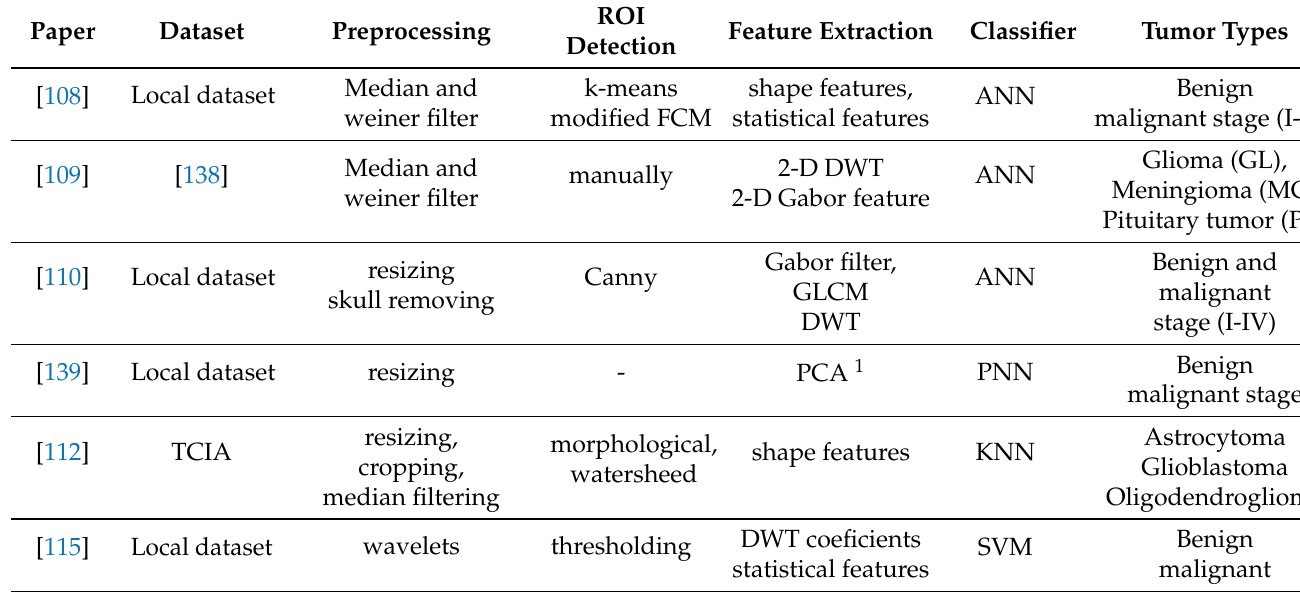
Table 6. Summary of conventional ML based brain tumor classification